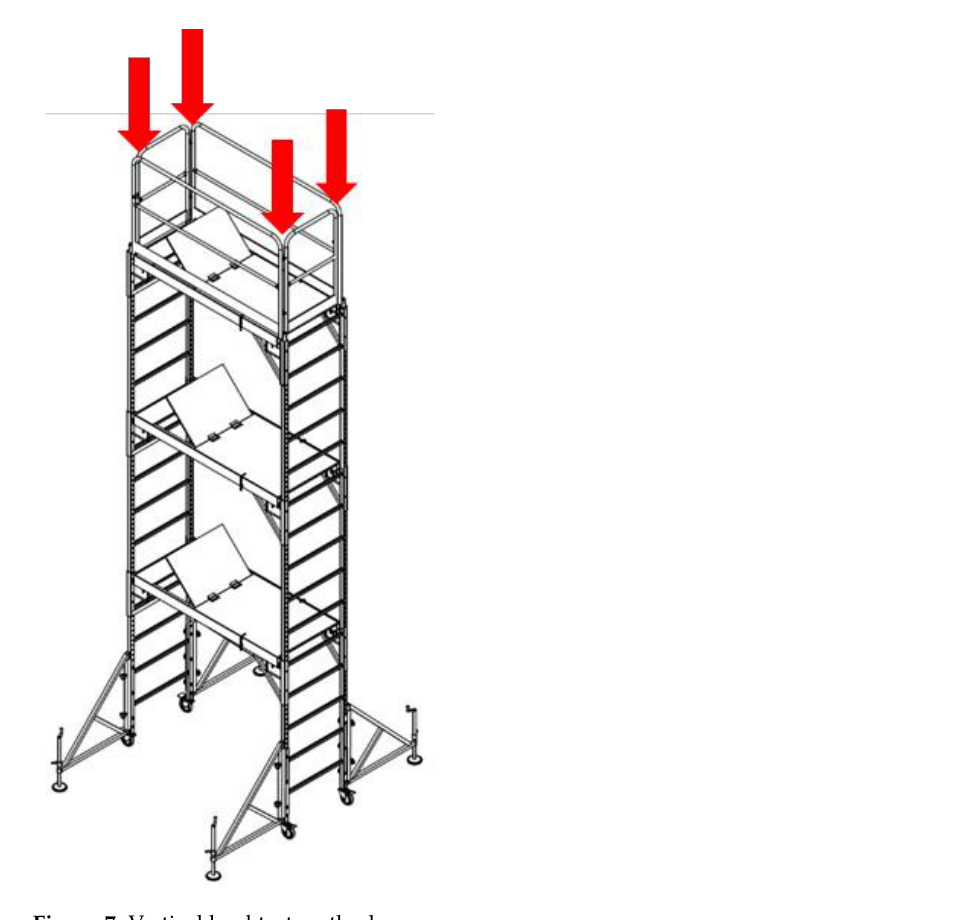
Figure 7. Vertical load test method.